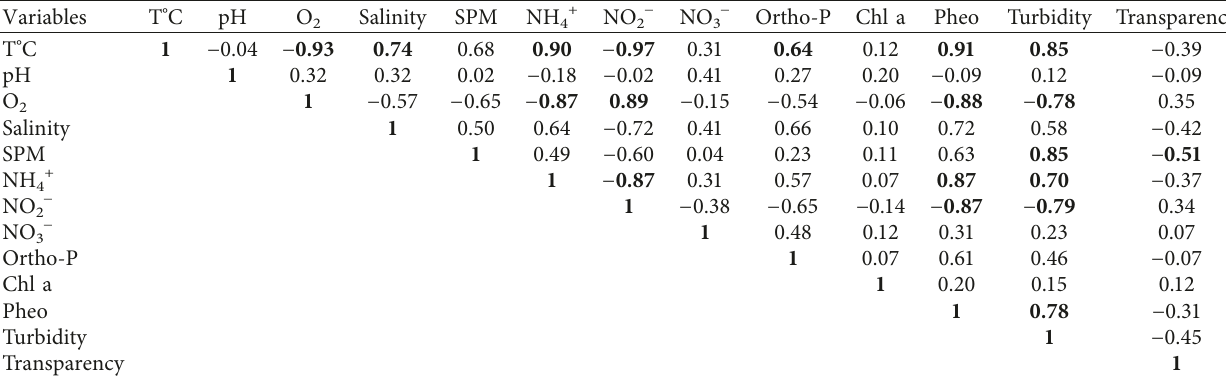
Table 2: Pearson correlation matrix of water quality variables of the South Lagoon of Tunis.